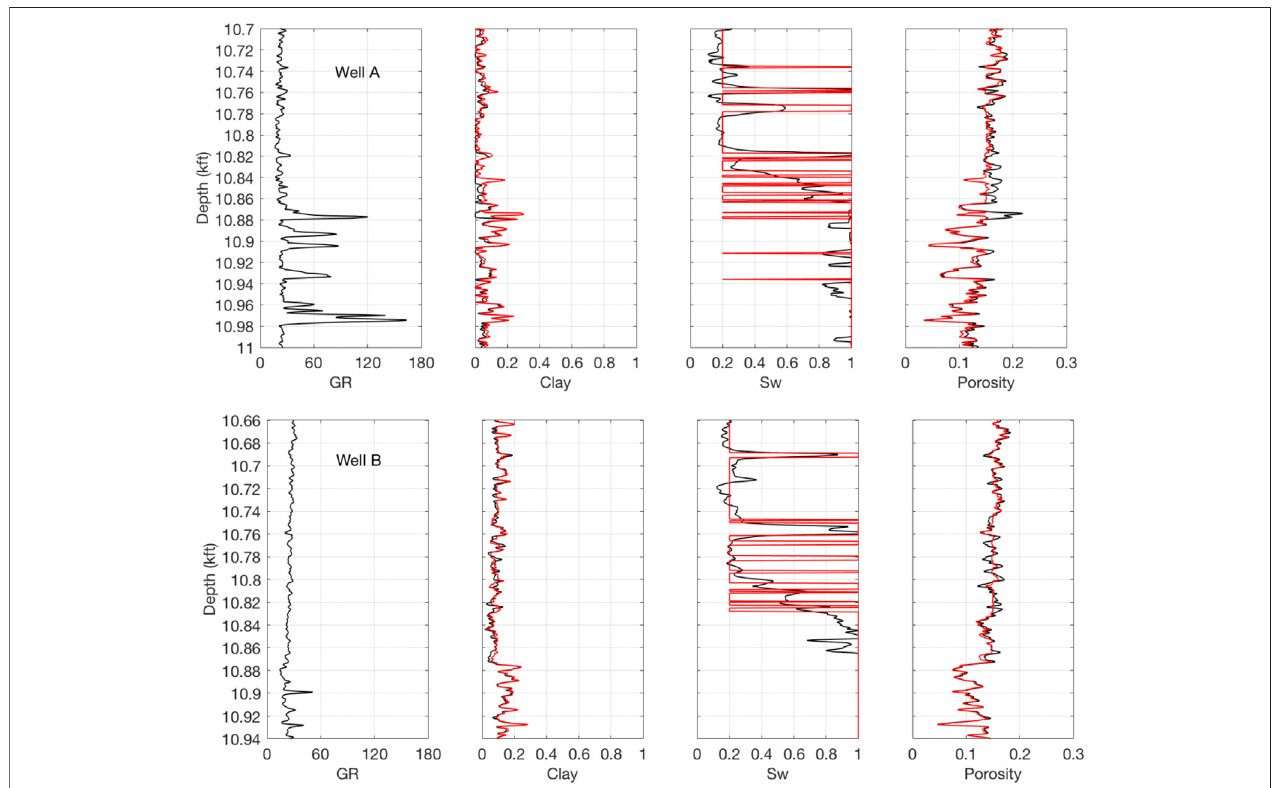
FIGURE 9 | Interpretation results (red) for Well A (top) and Well B (bottom) . The measured variables are shown in black.